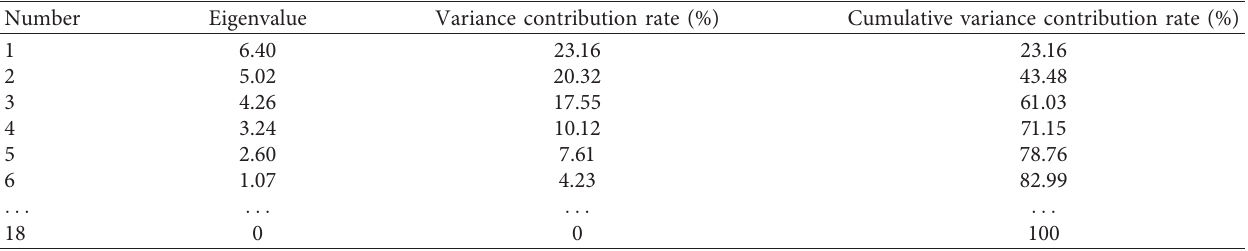
Table 3: Eigenvalue and variance contribution of the input